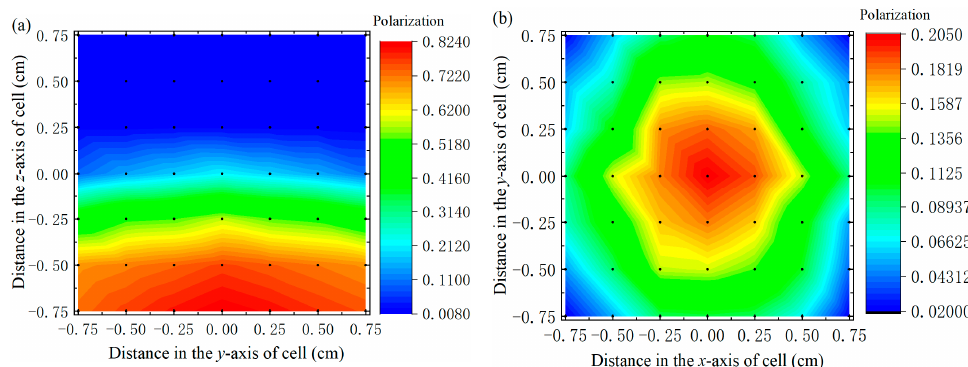
Figure 6. Experimental measurement result of spatial polarizability distribution of xy and yz planes with a spatial resolution of 0.25 cm. Each side measures 7 × 7 space points, and each space point is measured three times. ( a ) The measurement results of the spatial polarizability distribution of xy plane, ( b ) The measurement results of the spatial polarizability distribution of yz plane.